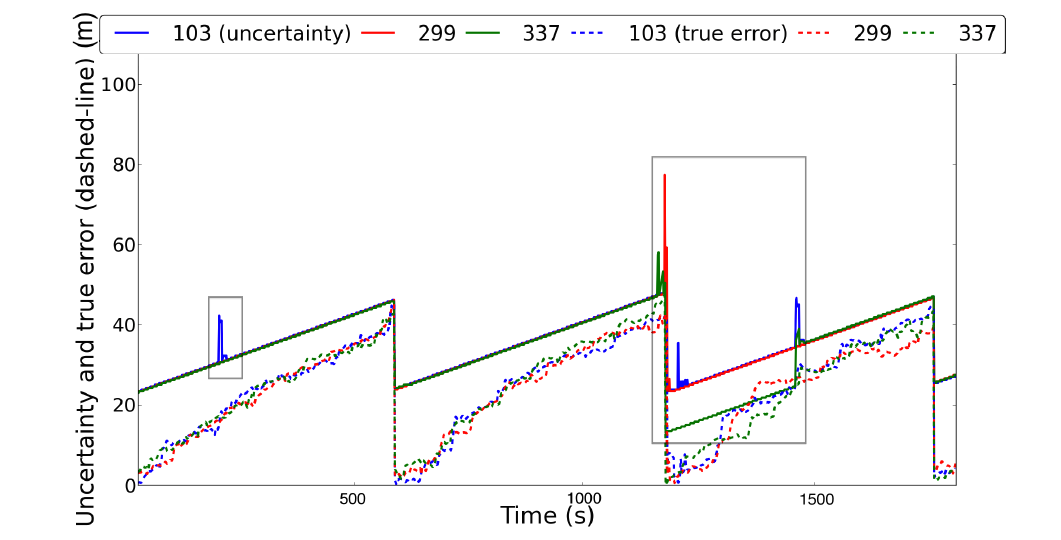
Figure 17. The growth of uncertainty with collaborative duty cycling. There are fewer motion detection events with group duty